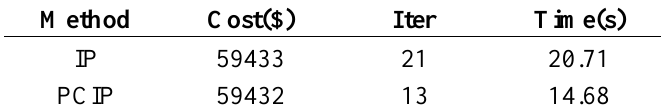
Table 3. Computational performances of two IP